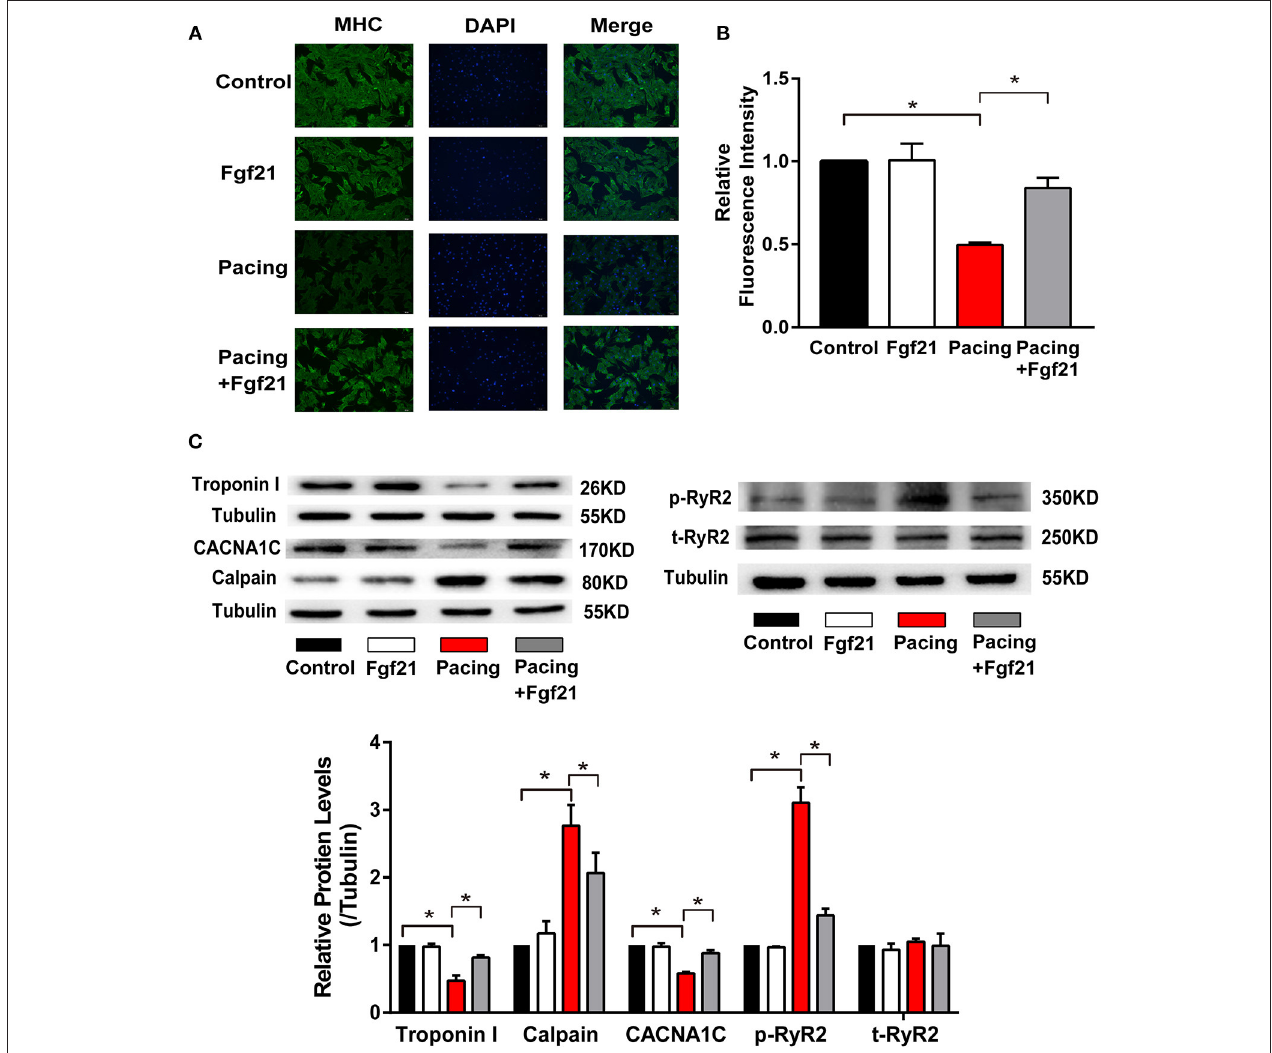
FIGURE 7 | Fgf21 protected against structural and electrical remodeling in the atria. (A) Immunofluorescence analysis was performed to analyze myosin heavy chain (MHC). (B) Summary of the relative fluorescence intensity of MHC in each group of HL-1 atrial cells. (C) The expression of Troponin I, CACNA1C, Calpain, p-RyR2, and t-RyR2 at protein levels in each group of HL-1 atrial cells. * p < 0.05.